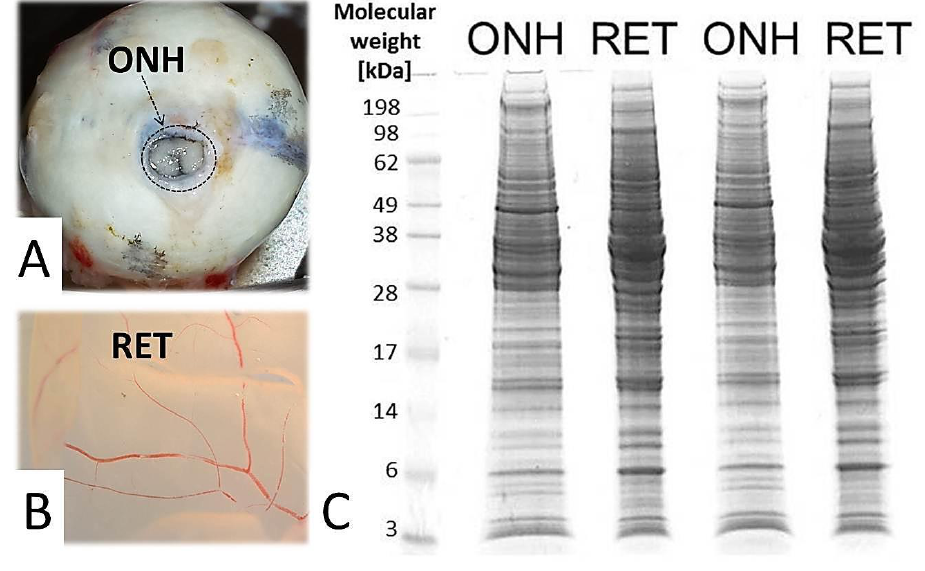
Figure 1. Sample preparation for comparative optic nerve head (ONH)/retina (RET) “bottom - up” high-performance liquid chromatography – electrospray ionization mass spectrometry BULCMS analysis. ( A ) Sample processing area (indicated by arrow and circle) of a porcine eye bulb corresponding to ONH tissue. ( B ) RET tissue isolated from the porcine eye bulb. ( C ) 1D SDS PAGE displaying ONH- and RET-specific migration pattern corresponding to the soluble tissue fraction. Gel lanes were used for tryptic in-gel digestion according to BULCMS analysis.